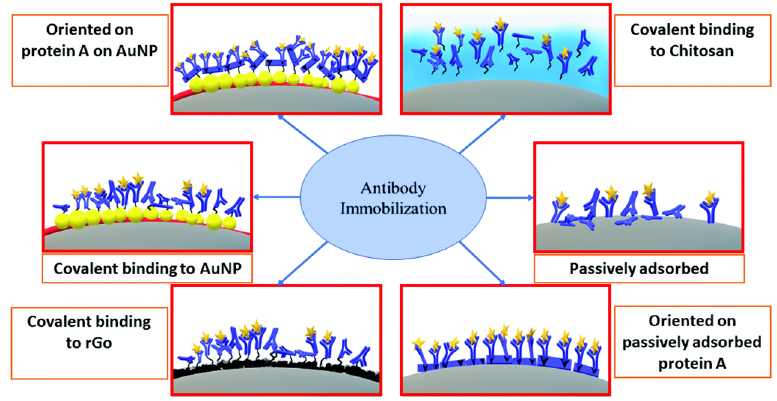
Figure 3. Different labels conjugated with the secondary antibody (Ab 2 ) during electro immunoassays performed on printed electrodes.